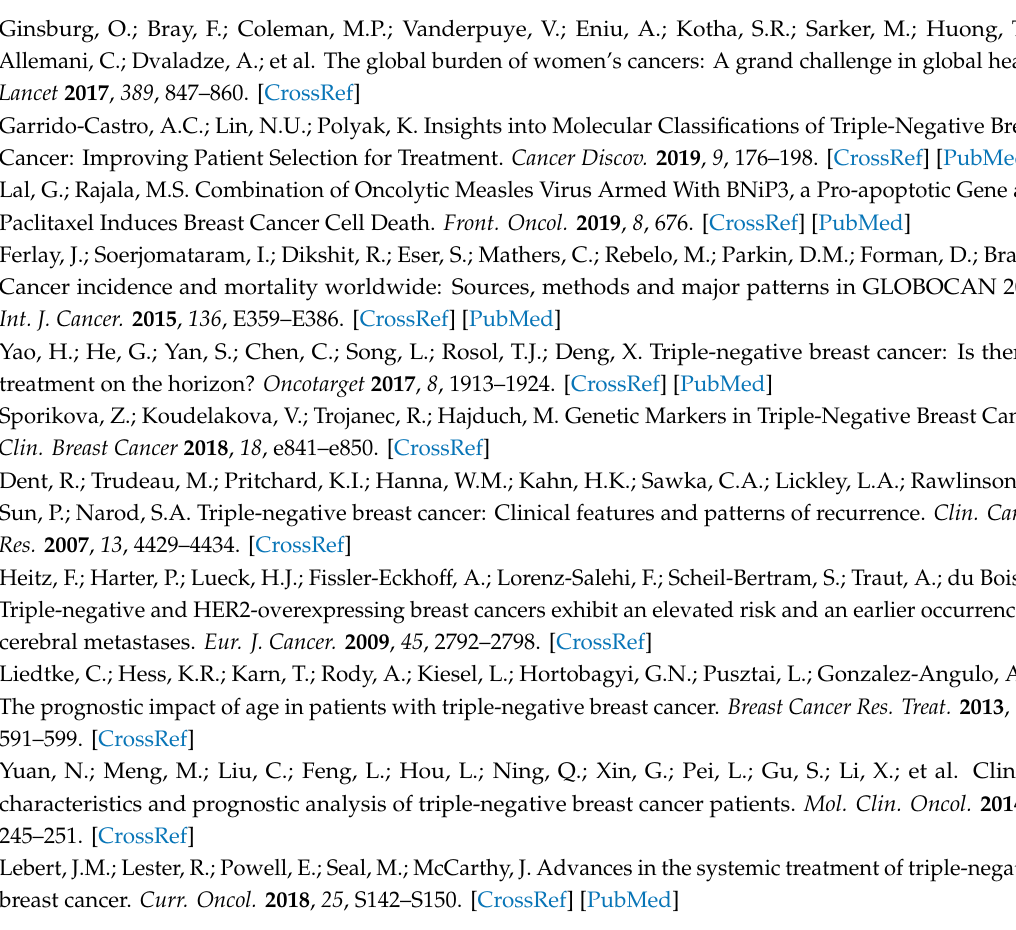
Figure S1: Immunoblots of Bcl-2, Bax, Bad, pBad, Cleaved Caspase 3 and Actin protein levels in MDA-MB 231 cells, Figure S2: Immunoblots of Caspase 8, Cleaved Caspase 8, Caspase 9, Cleaved Caspase 9 and Actin protein levels in MDA-MB 231 cells, Figure S3: Immunoblots of PARP and Actin protein levels in MDA-MB 231 cells, Figure S4: Densitometry readings / intensity ratio of each band. Table S1: List of down- and up- modulated genes between U94 and EGFP transduced cells determined by class comparison, using limma R package, performed on log2 normalized microarray